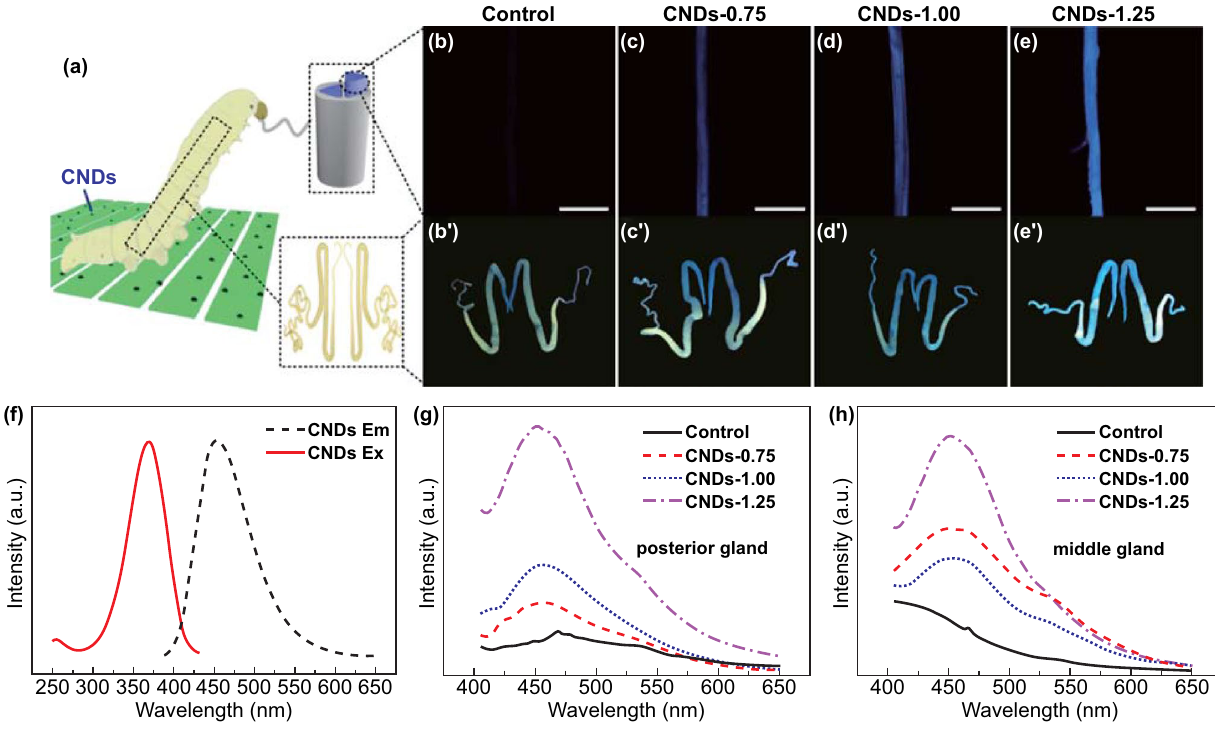
Fig. 2 Influence of CNDs additives on the intrinsic fluorescent intensity of silk. a Schematic of silkworm fed a CNDs‑modified diet and the corresponding silk gland and silk fiber. b – e Confocal laser scanning microscopy images of degummed silks (measured with an excitation wave‑ length of 405 nm). Scale bar represents 50 μm. b ′ – e ′ Ultraviolet (UV) pictures of silk glands of mature larvae measured under a UV lamp. b , b ′ Control, c , c ′ CNDs‑0.75%, d , d ′ CNDs‑1%, e , e ′ CNDs‑1.25%. f – h PL spectra of ( f ) CNDs, ( g ) posterior and ( h ) middle silk glands with an excitation wavelength of 370